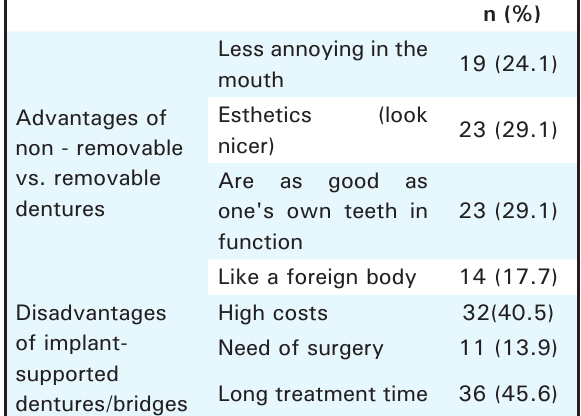
Table 3. Questions on advantages and